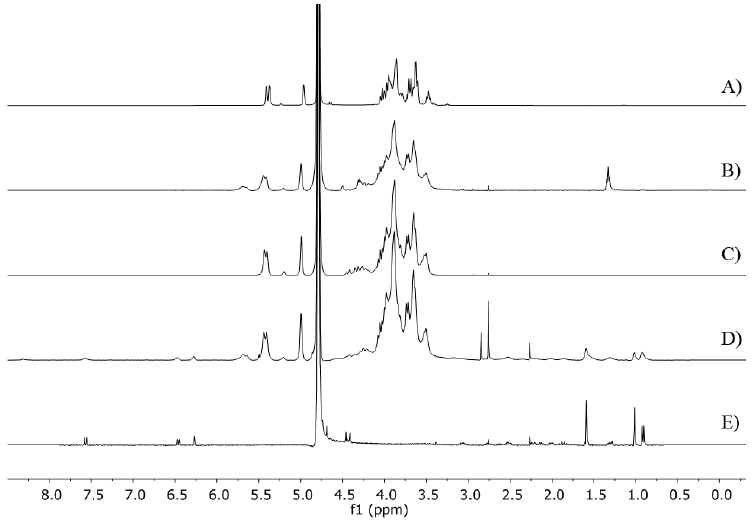
Figure 2. 1 H NMR (400 MHz) spectra of ( A ) pullulan, ( B ) carboxyethyl-pullulan, ( C ) carboxyhydrazide-pullulan, ( D ) pullulan-dexamethasone and E ) dexamethasone in D 2 O.